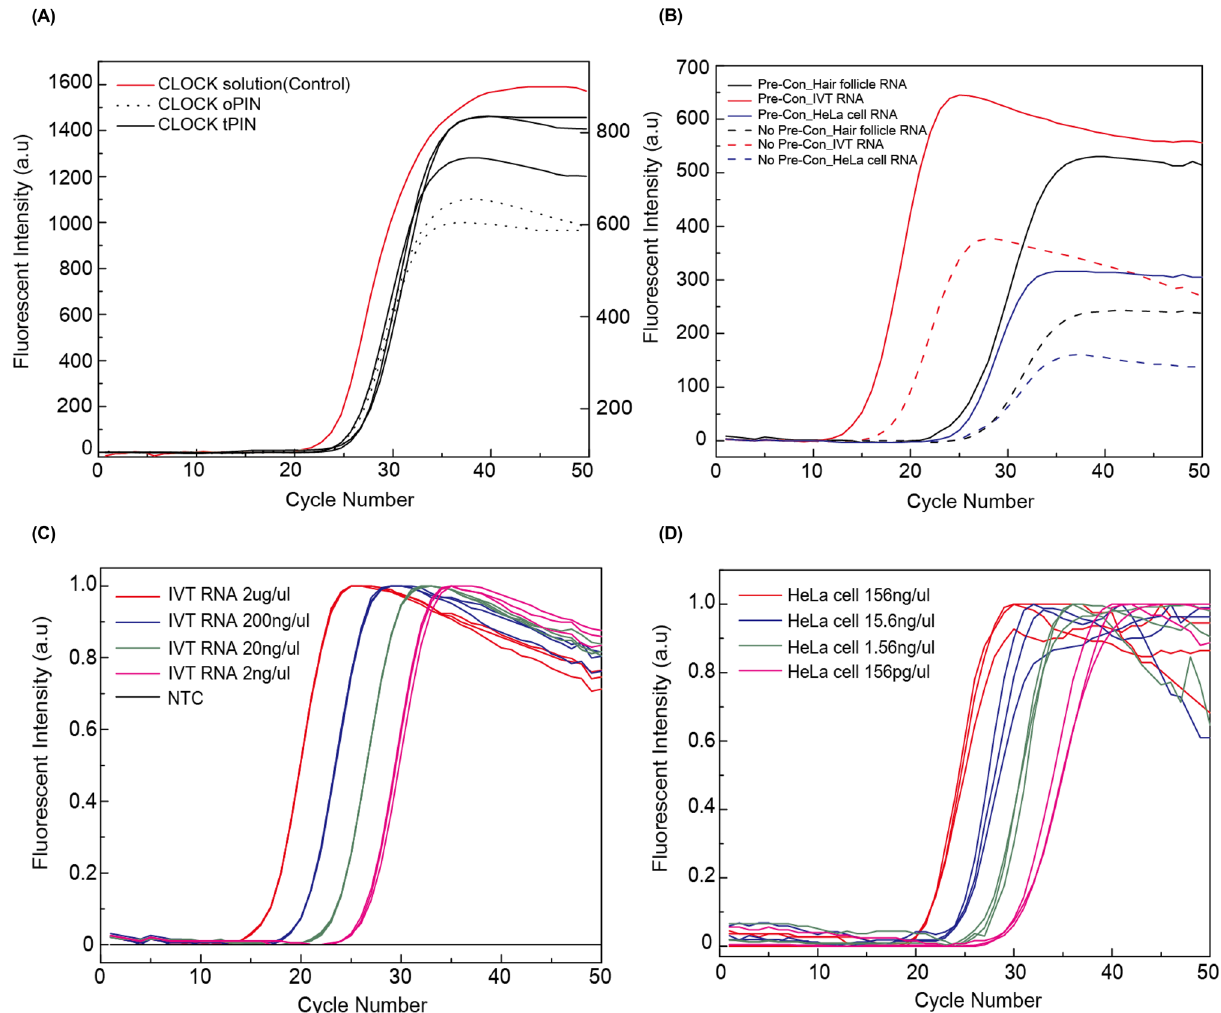
Figure 2. Validation of PIN(Primer-Immobilized Network) based PCR. ( A ) Comparison between the conventional solution and PIN (oPINand tPIN) based PCR. ( B ) Effect of pre-concentration (Pre-Con) step before incubation of PIN particles with one-step RT-qPCR mix from different RNA origins. In case of pre- concentration, the Ctvalues appeared early (~ 3) and enhanced fluorescent intensity was observed compared to non pre-concentrated ones. In case of HeLa cell RNA and hair follicle RNA, it was confirmed that this assay had a tenfold high sensitivity. ( C ) Concentration dependent one-step RT-qPCR graphs of the IVT RNA templates. Difference in Ct values were uniform (~ 3.3) corresponding to the ten-fold difference in template concentration. Interestingly, PIN based one-step RT-qPCRshowed no signals for NTC (No template control) until 50thcycle. ( D ) Limit of detection (LOD) test for HeLa cells using different concentration of total